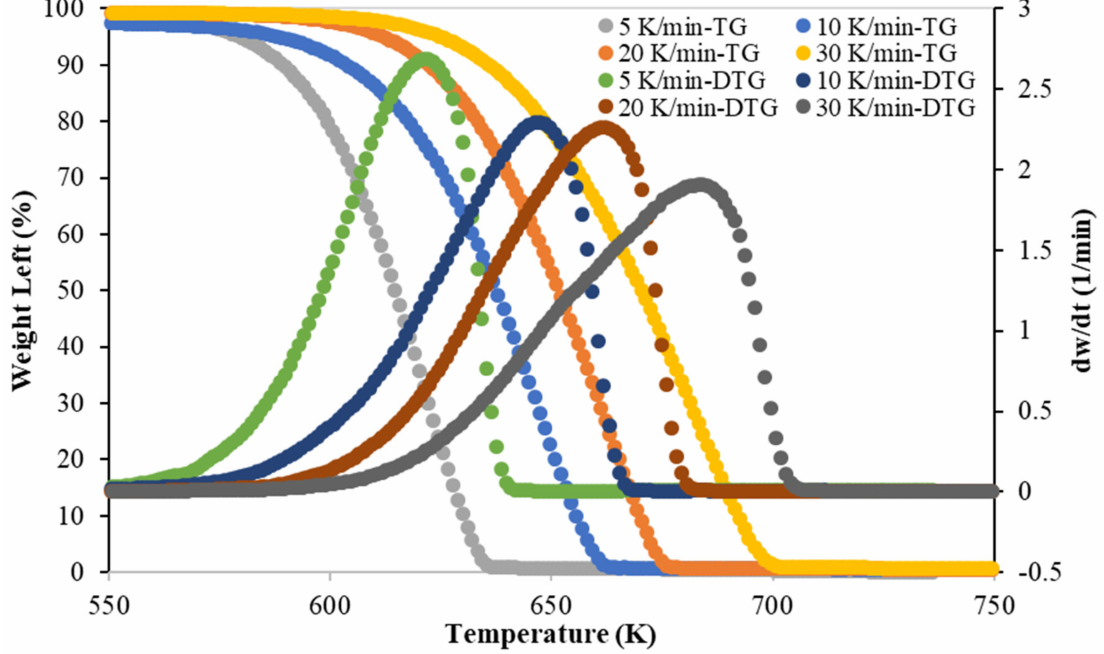
Figure 1. Thermogravimetric analysis (TGA) and Derivative thermogravimetric (DTG) curves for pyrolytic cracking of PLA at different heating